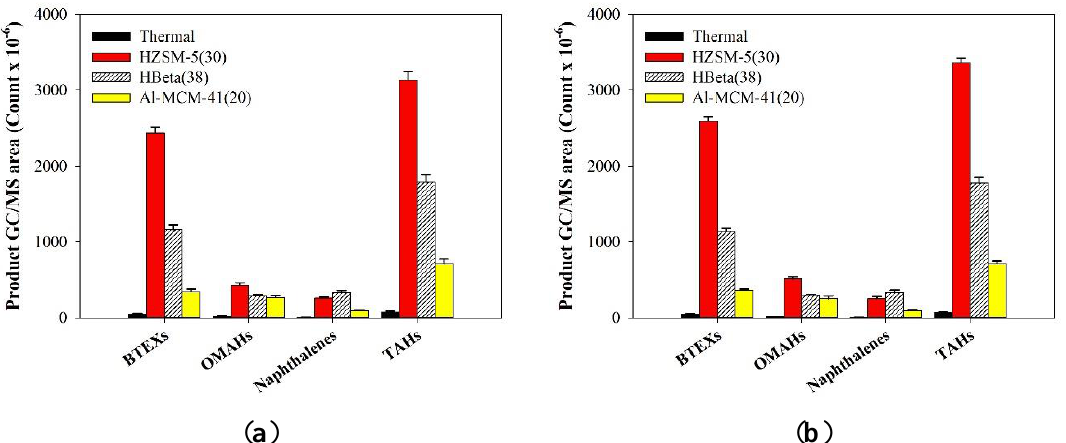
Figure 4. GC/MS peak areas (Count × 10 −6 ) of aromatic hydrocarbons obtained from the thermal and catalytic co-pyrolysis of SKP and SPE from ( a ) TP-1 and ( b ) TP-2 over HZSM-5(30), HBeta(38), and Al-MCM-41(20). BTEXs: benzene, toluene, ethylbenzene, xylenes; OMAHs: other mono-aromatic hydrocarbons; TAHs: Total aromatic hydrocarbons.